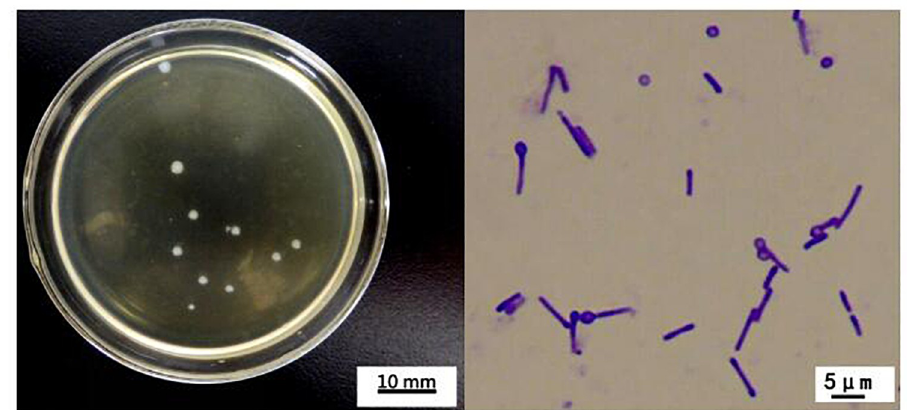
Fig 3. Colonial and cell morphology of C . sartagoforme XN-T4 .